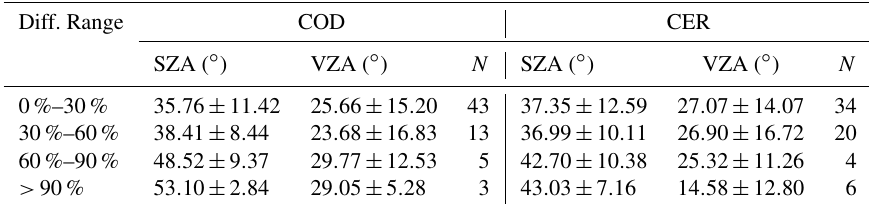
Table 2. Mean solar zenith angle (SZA) and viewing zenith angle (VZA) values for different levels of differences in water cloud properties observed by sky radiometer and SGLI. Diff. Range